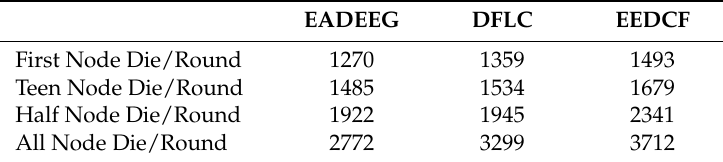
Table 5. Death time of nodes in some specific time points in Scenario 2.